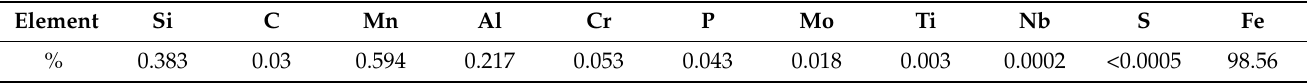
Table 1. Chemical composition of steel